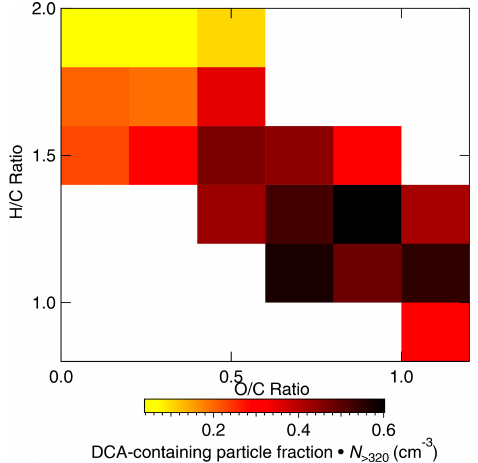
Figure 10. Scaled number concentration (PF · N > 320 ) of DCA- containing particles measured by the ALABAMA (coloured) as a function of the HR-ToF-AMS estimated oxygen-to-carbon (O / C) and hydrogen-to-carbon (H / C) during the Arctic air mass period. Uncertainty analysis is given in Sect.